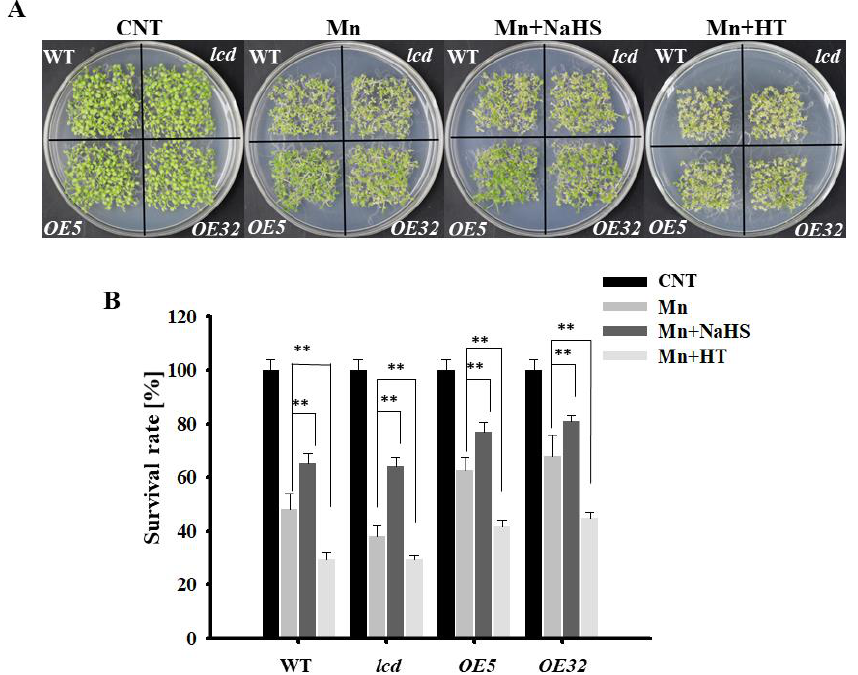
Figure 3. Effects of NaHS and HT on the growth of lcd and OELCD under Mn stress. Effects of NaHS and HT on the phenotype ( A ) and survival rates ( B ) of wild type, lcd , and two independent overexpression Arabidopsis seedlings after Mn stress. Three independent experimental replications were conducted. Values are the means ± SE of three independent experiments (** p < 0.01).